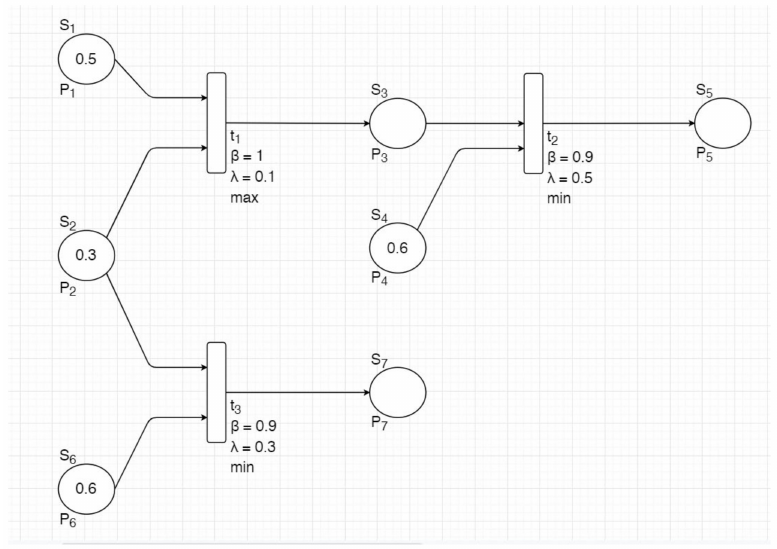
Figure 4. An example of a fuzzy Petri net with two different transitions that have a mutual